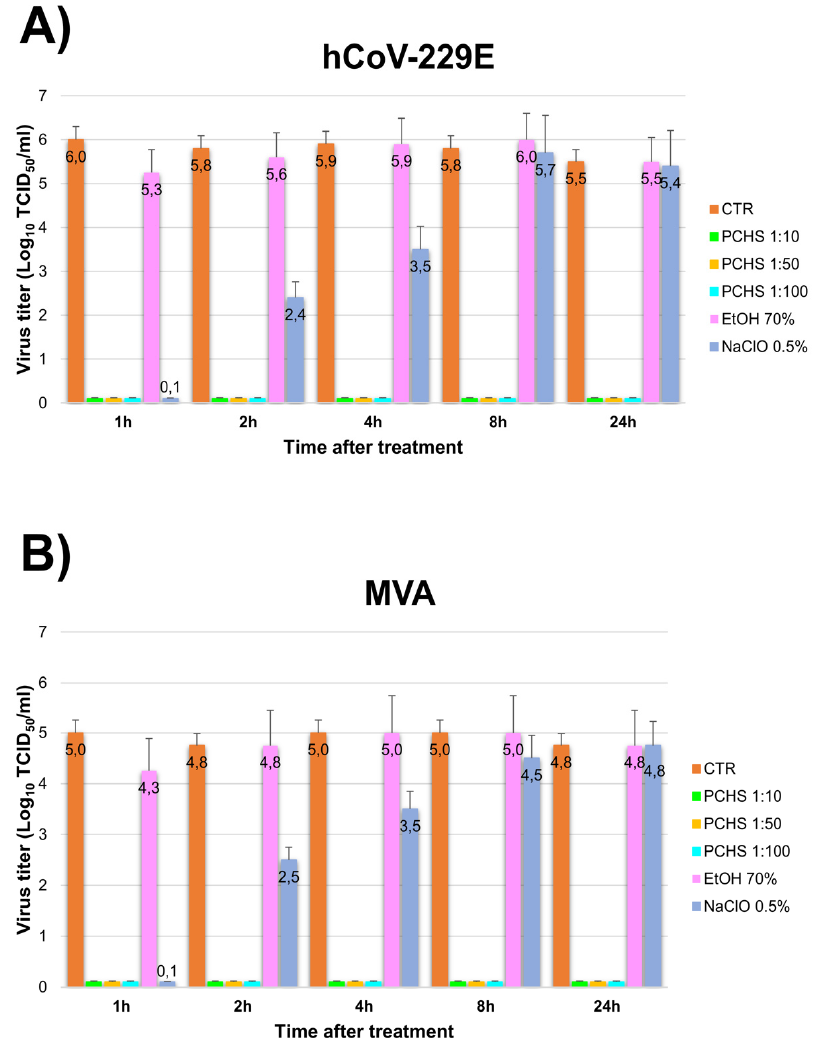
Figure 4. Long-term ability of PCHS to prevent virus contamination on treated surface. Assays were performed by applying PCHS on surface (dilutions 1:10, 1:50, and 1:100), left to dry and left on surface for 1, 2, 4, 8, and 24 h. Afterwards, treated surfaces were contaminated with the indicated viruses. After 2 h, samples were collected and the residual virus titre was evaluated by Spearman-Karber method. As controls, 70% EtOH and 0.5% NaClO were used; results are expressed as Log 10 TCID 50 / mL , and represent the mean ± SD values of duplicate samples from three independent assays. ( A ) hCoV-229E results. ( B ) MVA results.